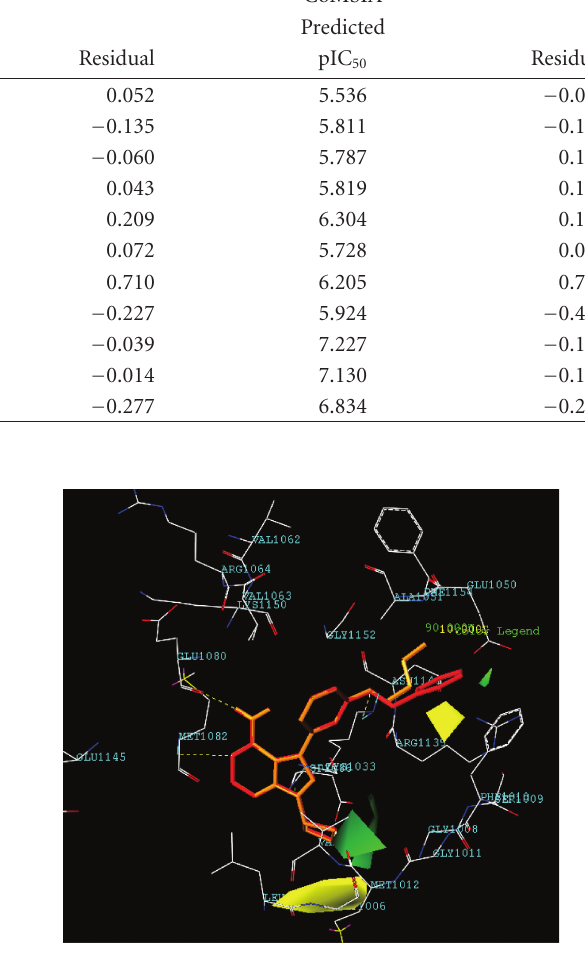
Figure 1: Comparison of minimum energy (yellow) and docking based (red) conformers.